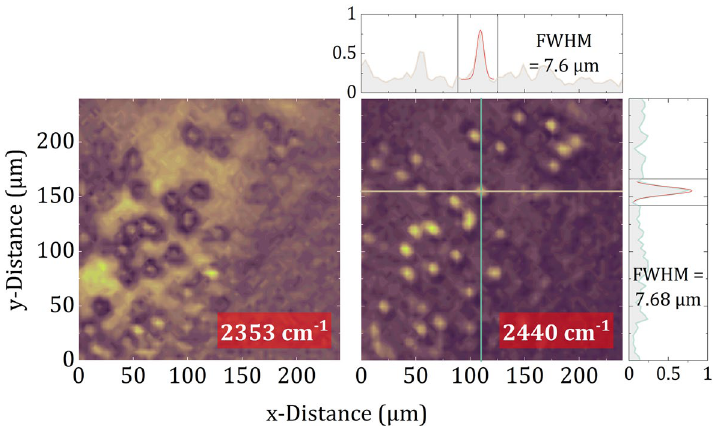
Figure 5. MIR SPI microscope images of human red blood cells. Spectral images at two exemplary 1 1 wavenumbers (2353 cm − and 2440 cm − ) have been extracted from the acquired hyperspectral data cube and plotted as normalized intensity images. The indicated profiles through an exemplary blood cell reveal a FWHM of about 7.6 µ m , which is in agreement with the expected cell diameter.